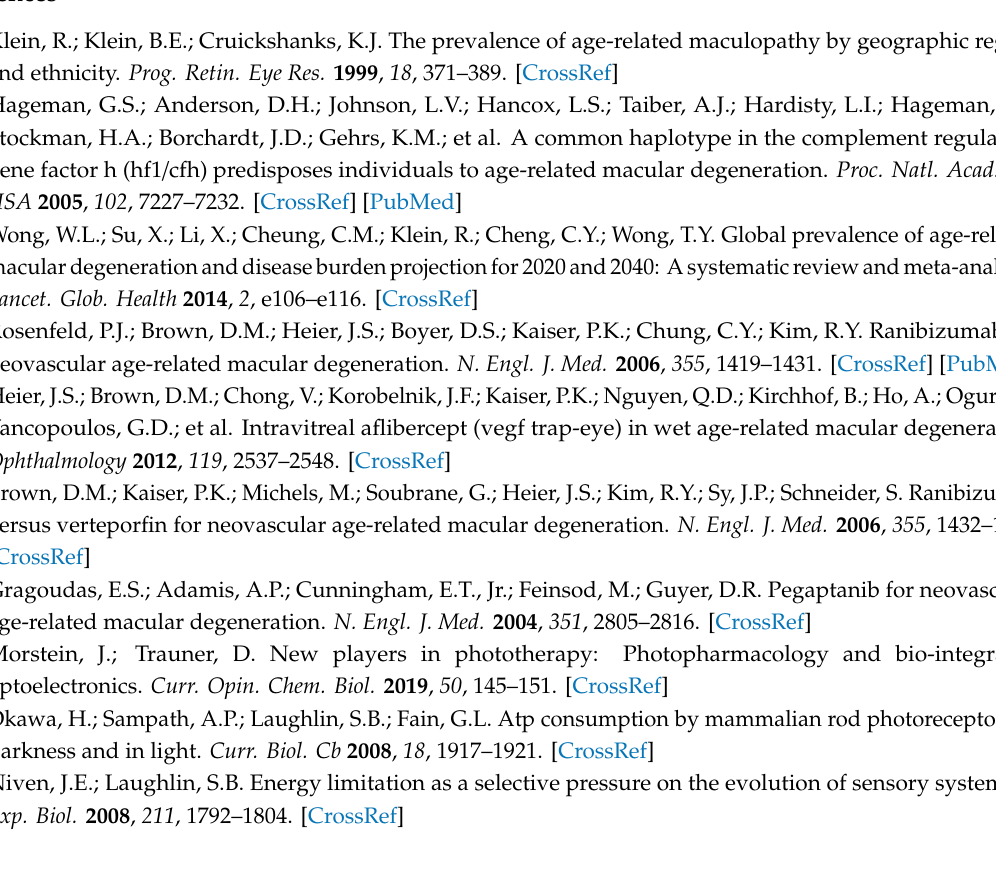
Table S1. Genomic coordinates of HREs relative to the TSS, Table S2. Primer used to amplify human DEPP promoter, Table S3. Sequence of the 3759 kb regulatory region (5’ → 3’), Table S4. Primers used to generate BLOCKs, Table S5. Primers used for 5’ end truncations, Table S6. Primers used for site directed